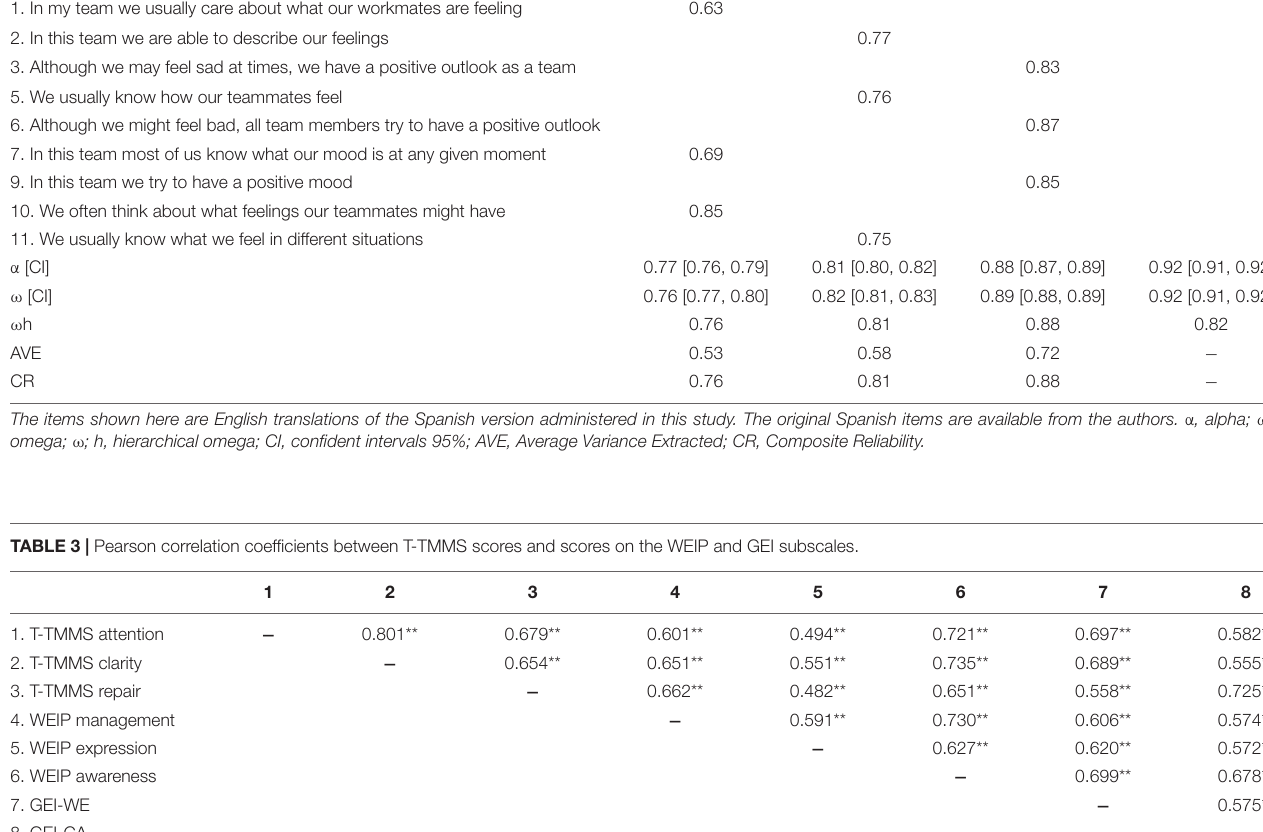
TABLE 2 | Final 9-item version of the T-TMMS after eliminating the problematic ones. Items